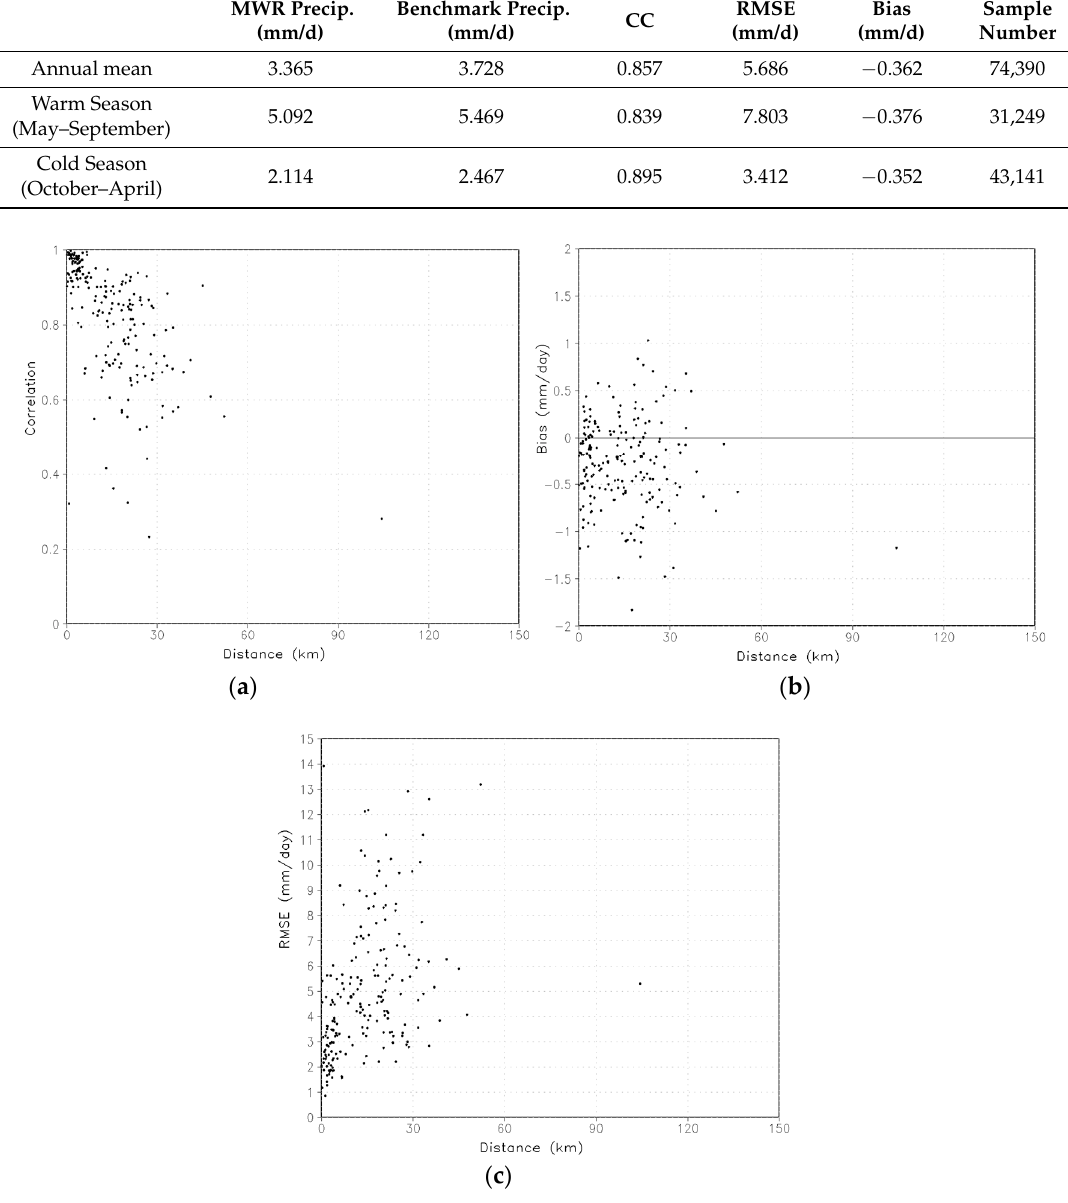
Figure 3. Scatter plots between the ( a ) correlation coefficient, ( b ) bias and ( c ) root mean square error (RMSE) and the distance from the hydrological station to its nearest benchmark station.